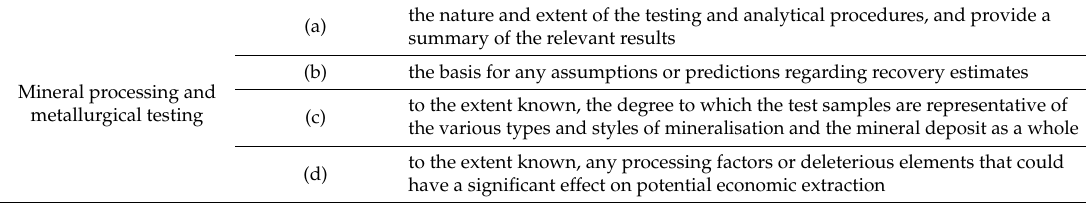
Table 27. Extract from NI43-101 Item 13 pertaining to metallurgical testwork (from [27]).